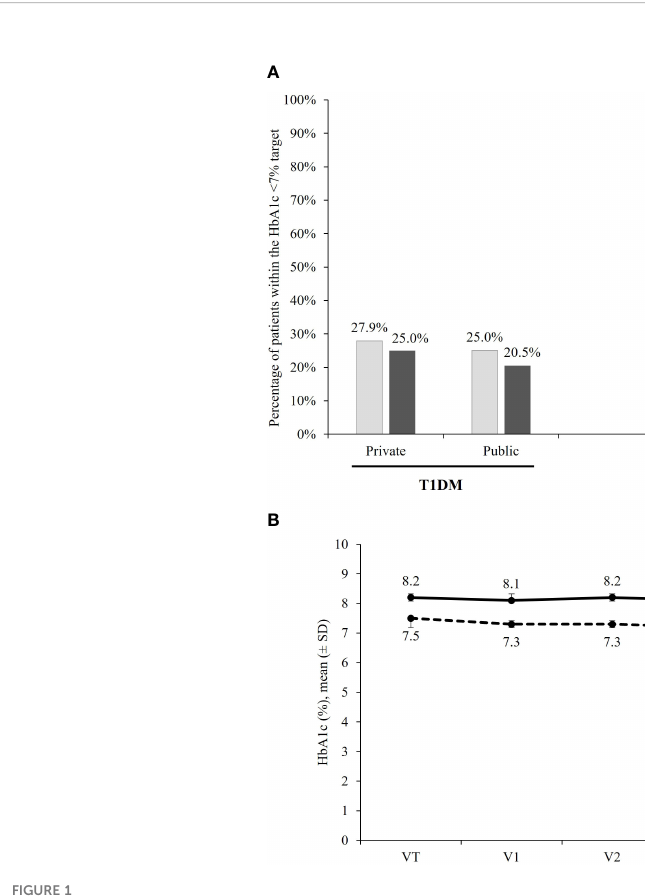
TABLE 5 Changes in BMI from baseline to the fi nal follow-up (after 2 years).